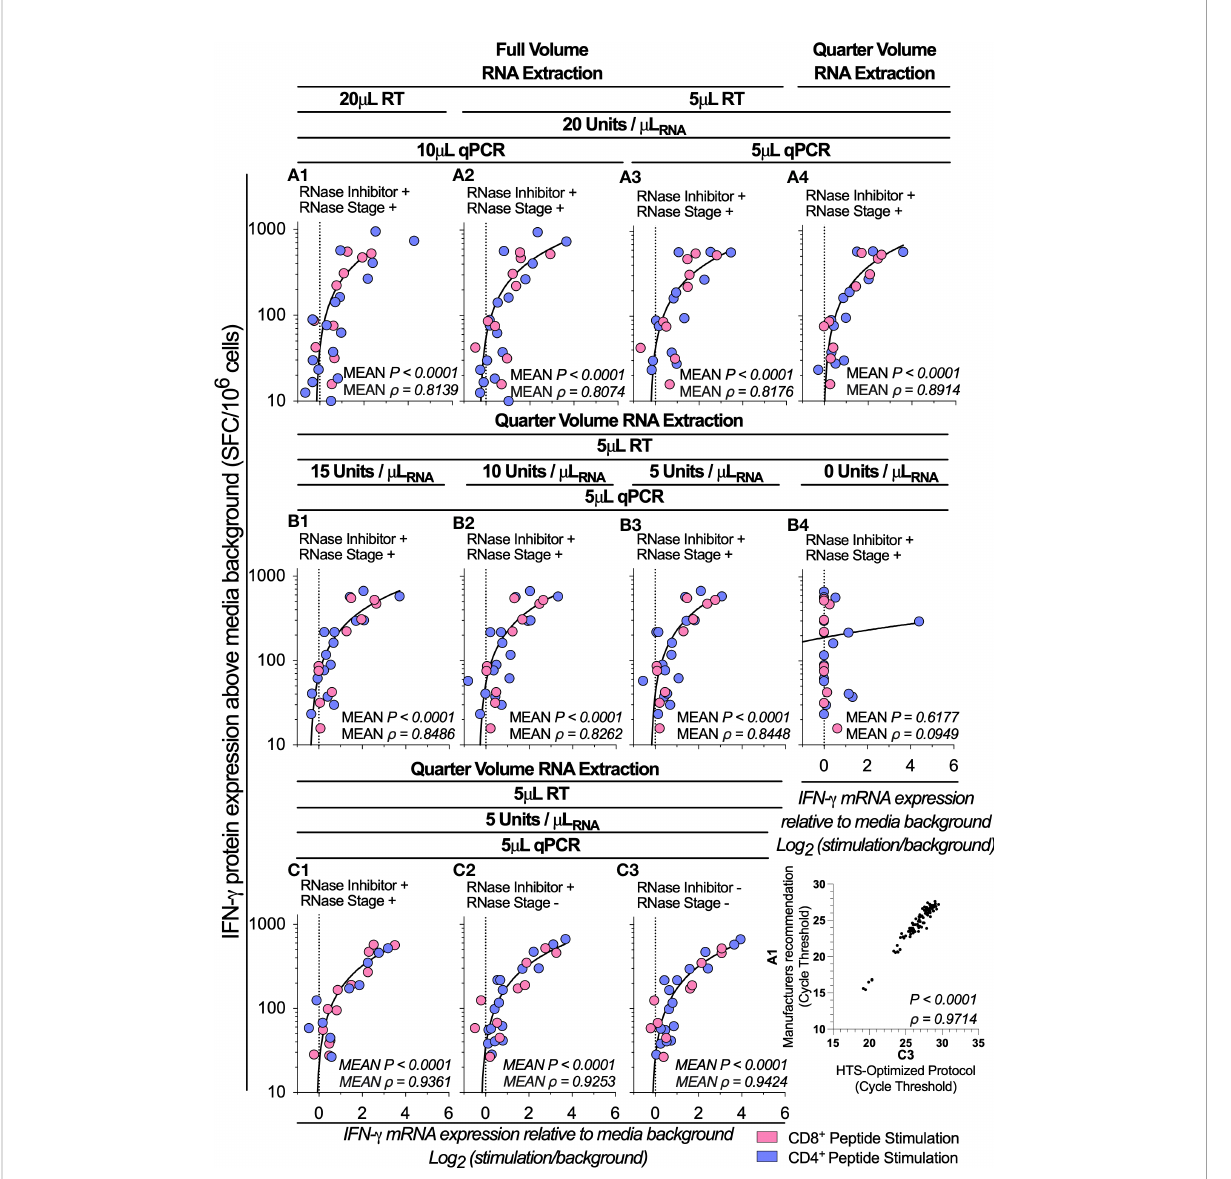
FIGURE 1 Assay optimization. IFN- g mRNA expression by RT-qPCR correlated to IFN- g protein production by ELIspot across various test conditions denoted A1-A4, B1-B4 and C1-C3 following stimulation of PBMCs (1x10 5 ; n=5) with peptides representing two well-de fi ned CD4 + (Blue Dots) T cell peptide-epitopes (In fl uenza 57-71 KGILGFVFTLTVPSE and In fl uenza 260-284 ARSALILRGSVAHKSCLPACVYGP) and two CD8 + (Pink Dots) T cell peptide-epitopes (In fl uenza 58-76 GILGFVFTL and Epstein Barr Virus 280-288 GLCTLVAML). Conditions A1-A3 were evaluating the correlation between RNA isolation, cDNA synthesis and qPCR reagent miniaturizations; B1-B4 were evaluating the correlation between reverse transcription (RT) reactions containing the Superscript IV enzyme at a concentration of 15, 10, 5, and 0 units/ m L RNA ; and C1-C4 were evaluating the correlation between reverse transcription (RT) reactions including RNase Inhibitors and a post-cDNA synthesis RNase digestion stage, and reactions excluding the RNase digestion stage; and RT reactions excluding the RNase digestion stage and RT reactions excluding both the RNase digestion stage and RNase Inhibitors. Shown are the mean gene copy number of technical triplicate RT-qPCR assays correlated to mean of triplicate IFN- g spot forming cells (SFC) by ELIspot, with both mRNA and protein measurements corrected for background. The technical means of qPCR cycle threshold values (Ct value) combined (for all tests and controls) were correlated between test conditions A1 and C3 . ELIspot data <10 SFC/10 6 were graphically omitted. The strength of each association was tested by Pearson ’ s correlation on log-transformed data, with P values and Pearson ’ s correlation coef fi cient ( r )